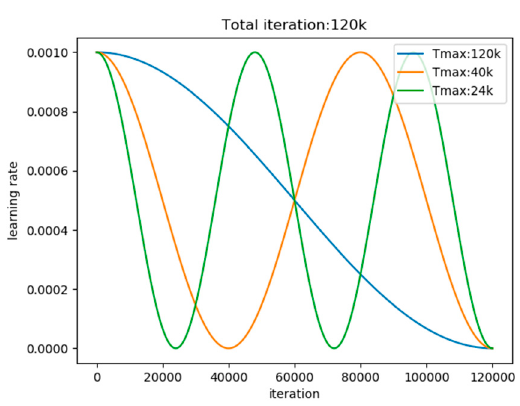
Figure 6. The cosine annealing leaning rate in different Tmax.